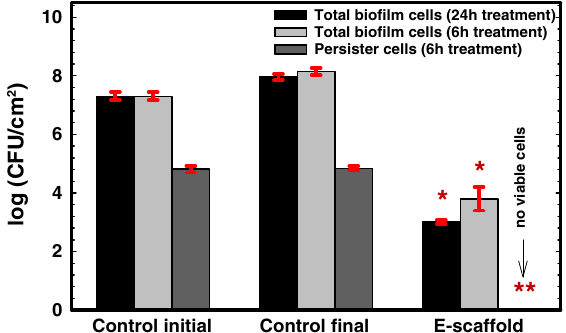
Fig. 2 Exposure to e-scaffold eradicates the persister cells in P. aeruginosa PAO1 bio fi lms. Bars represent means of logarithms of colony-forming units of viable bio fi lm cells. Error bars represent the standard errors of the means from three biological replicates. The symbol * denotes a signi fi cant difference compared to total bio fi lm cells ( n = 3, P < 0.05, one-way ANOVA), and ** denotes a signi fi cant difference compared to control initial persister cells ( n = 3, P < 0.001 , one-way ANOVA)